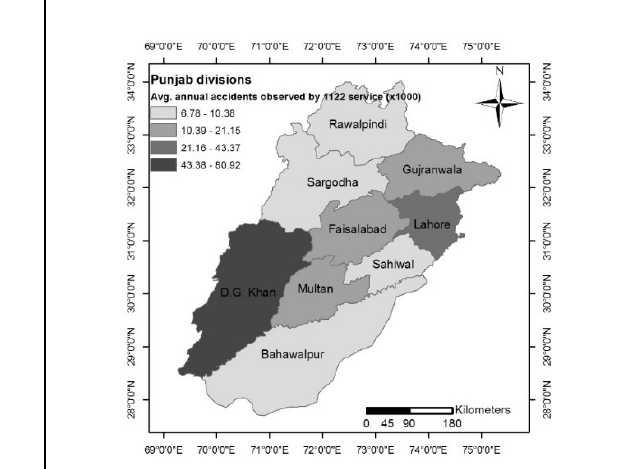
Fig.12: Avg. Annual Road Accidents (Estimated by